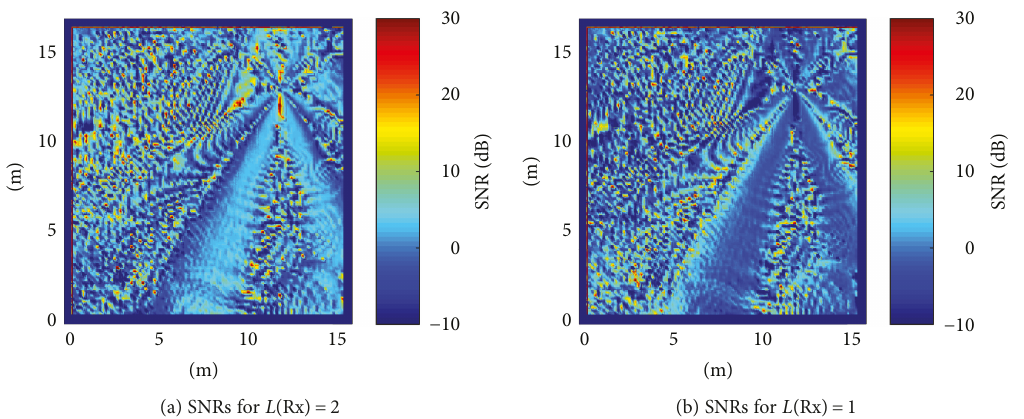
Figure 9: SNRs calculated for the lecture room with the transmitter of L